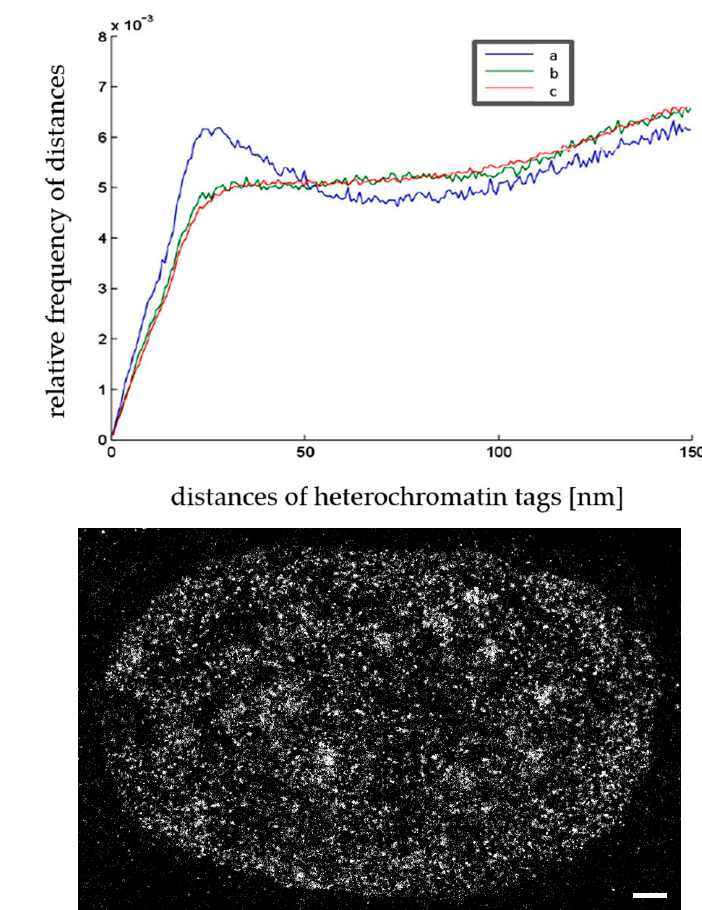
Figure 3. ( A ) Relative frequencies of the pair-wise distances (in nm) of heterochromatin tags (H3K9me3) labelled with a secondary antibody, carrying rhodamine red X. The curves obtained from 20 cells each (time-stacks of 3500 frames per cell) indicate compaction regions ( ≤ 100 nm) in a more randomly organized environment for wild-type U2OS cells (a). Treatment with etoposide resulted in a relaxed configuration for wild-type U2OS cells (b) and Smad specific ubiquitin protein ligase 2 (Smurf2) over-expressing U2OS cells (c). For comparison and explanation of the curves in Figure. 3A, see Figure 1C; ( B ) example of an image of a cell nucleus from a U2OS cell, reconstructed from the loci matrix of heterochromatin tags (Scale bar: 1 μ m).